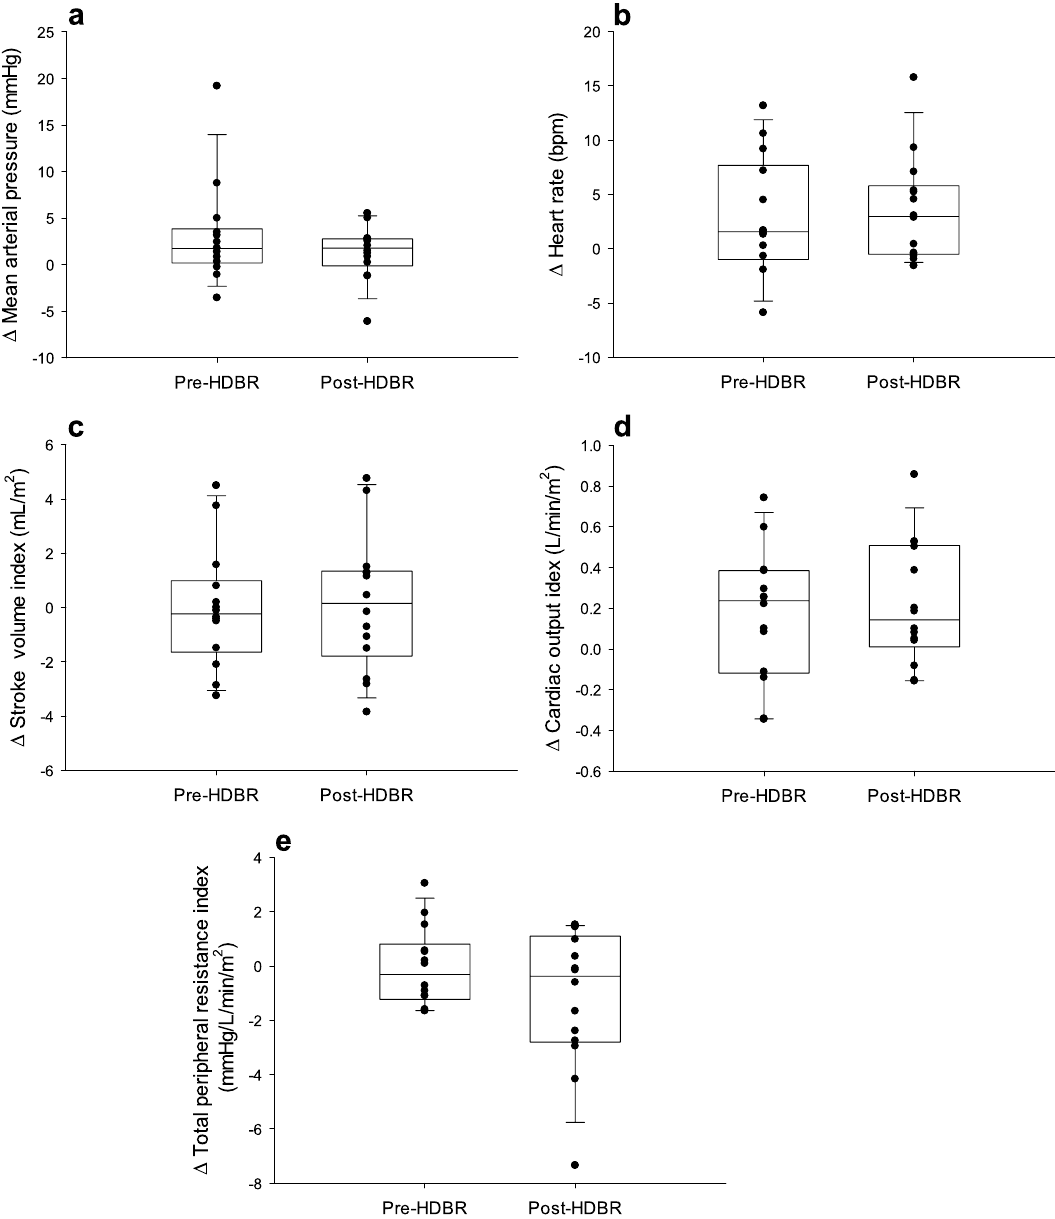
Figure 2. Change in mean arterial pressure (a) , heart rate (b) , stroke volume index (c) , cardiac index (d) , and total peripheral resistance index (e) from baseline to 5 min hypercapnia. The line within each box indicates the median, whereas the lower and upper boundaries indicate the 25th and 75th percentiles. Lower and upper whiskers represent the 10th and 90th